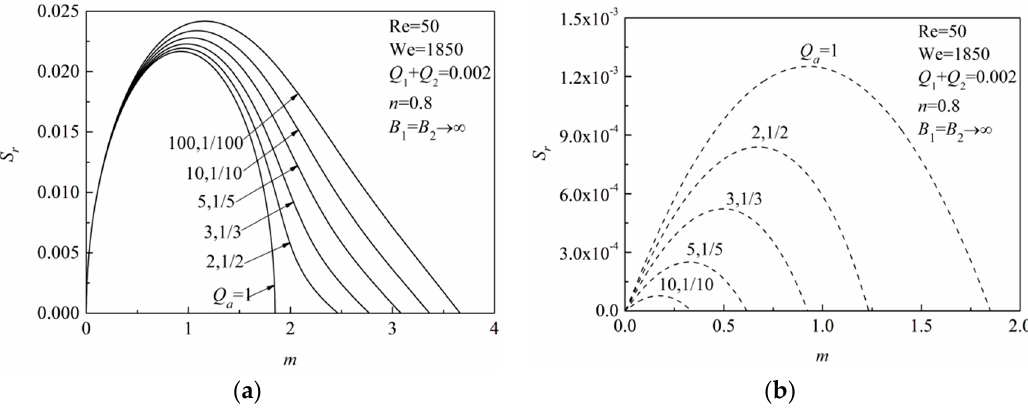
Figure 5. The dimensionless growth rate S r of disturbance waves as a function of the non-dimensional wave number m for different asymmetric degree of aerodynamic forces Q a : ( a ) para-sinuous mode (solid line); ( b ) para-varicose mode (dash line).